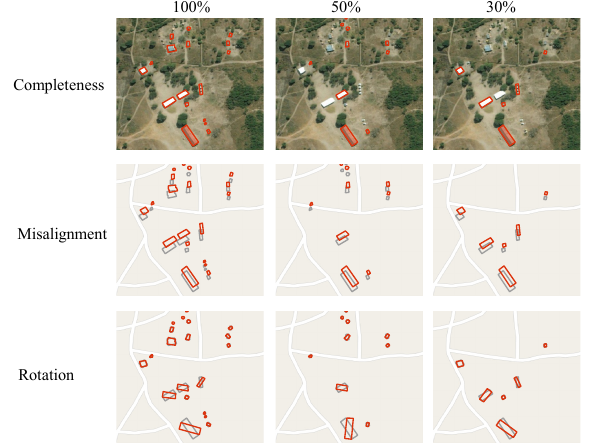
Figure 5. Illustrations of simulated error sources in training data. Basemaps contrast to Bing aerial